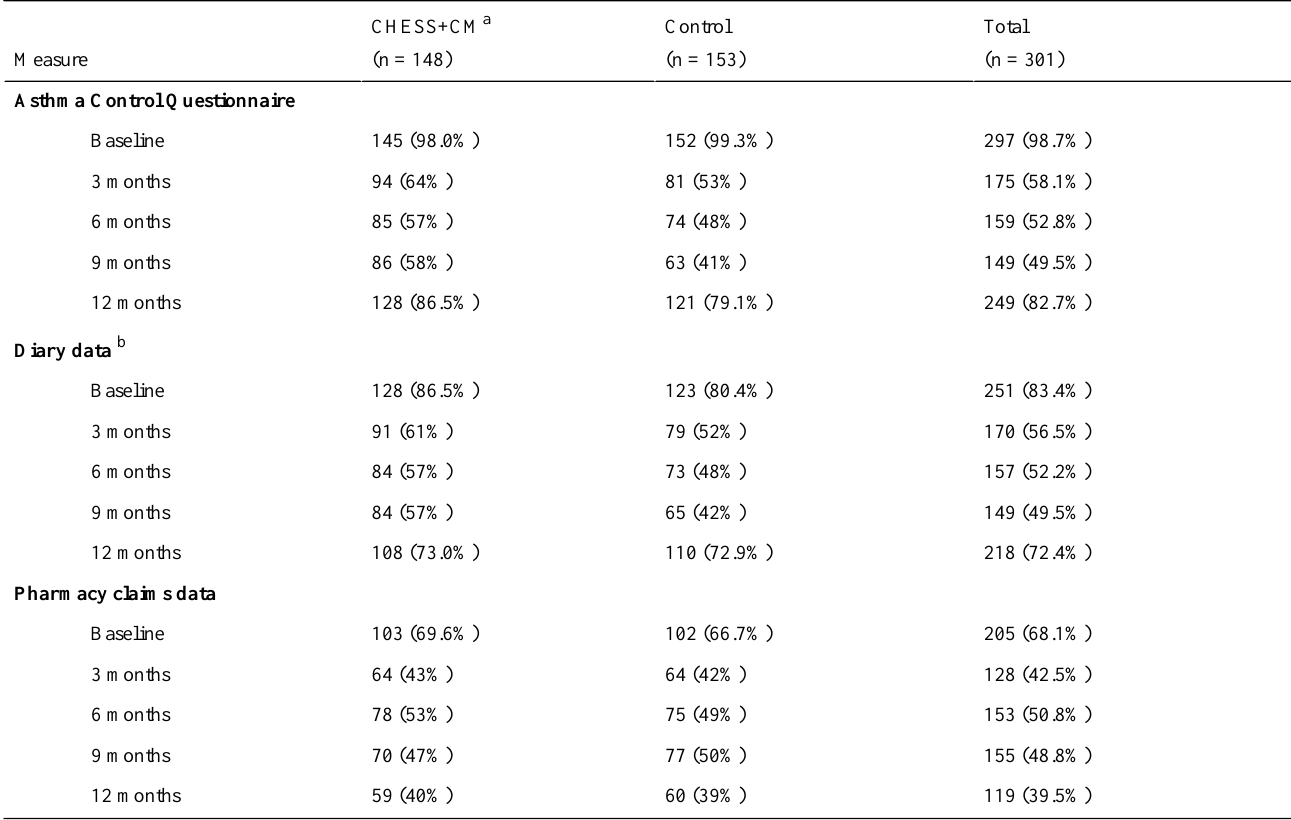
Table 1. Response rate and available data at study time points.